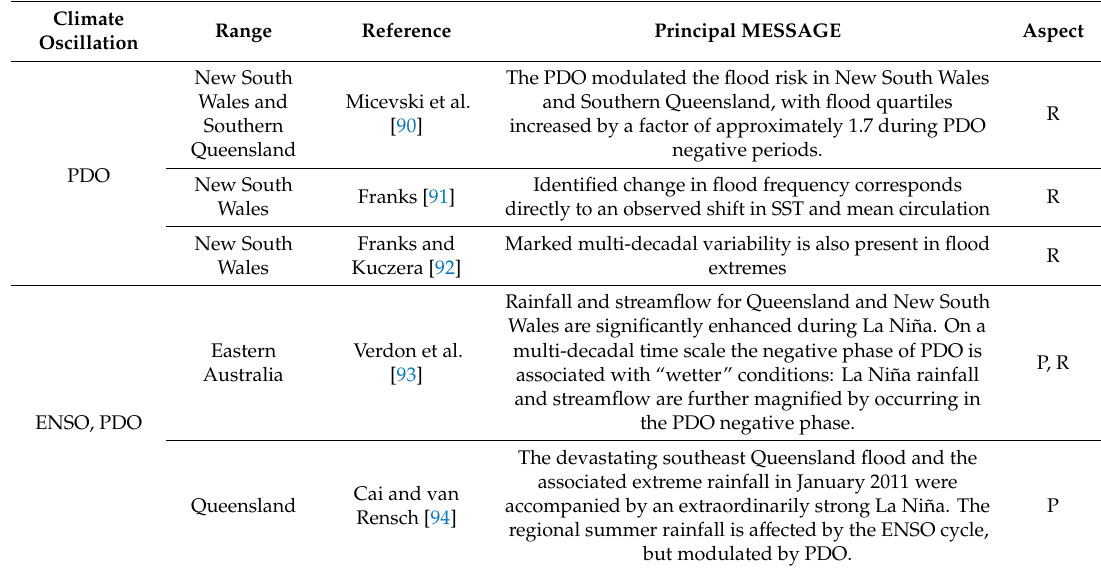
Table 6. Review of links between climate oscillation and floods for Australia, as reported in the literature. Aspects of reference in the rightmost column—as in Table